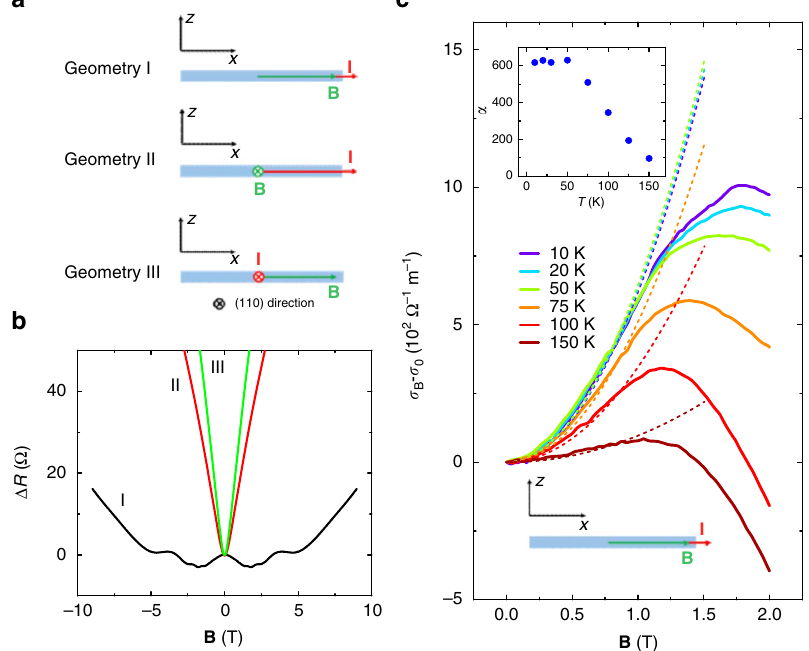
Figure 2 | Chiral anomaly induced negative longitudinal MR in sample N1. ( a ) MR in three different geometries in transport measurements at 2.5K. ( b ) The negative MR only appears when E is parallel with B . The control experiments with geometries II and III exclude the crystal anisotropy effect on the observed negative MR. ( c ) The magneto-conductance change s B – s 0 at different temperatures, following a quadratic dependence, and it decreases after a critical field. The inset summarizes the fitting coefficient a at different